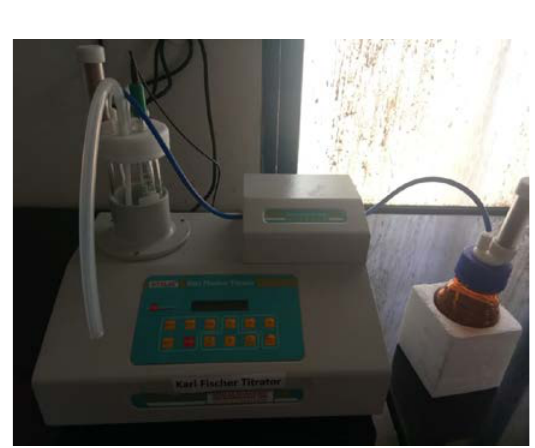
Figure 6: Experimental setup for sulphur content test as per IS:1448 (Part-33) standards.